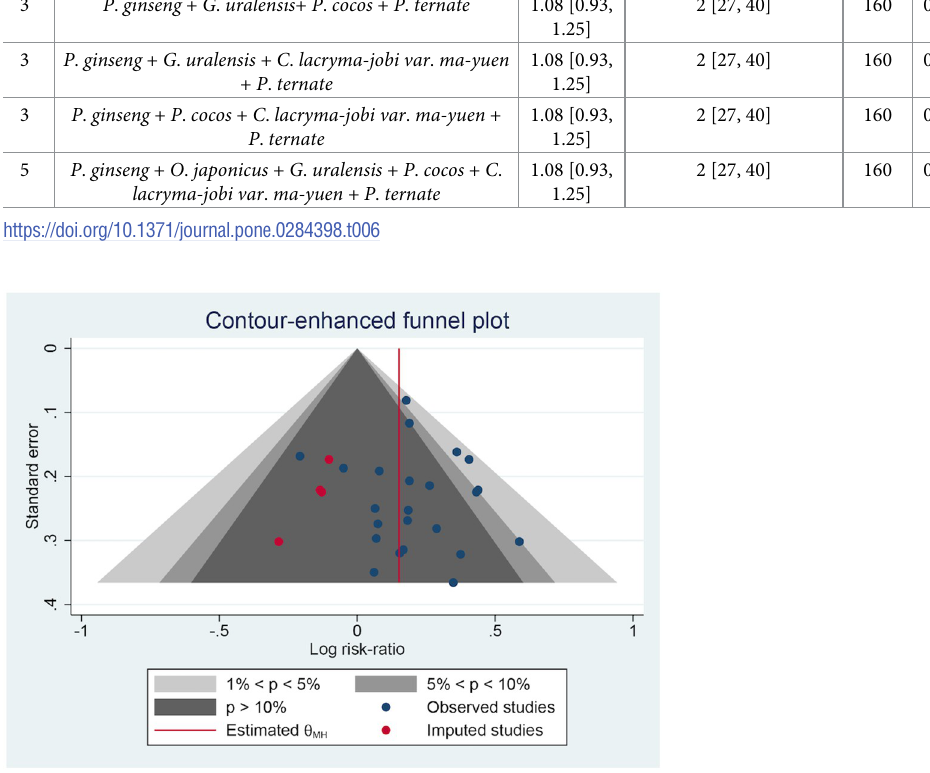
Fig 10. The contour-enhanced plot of the